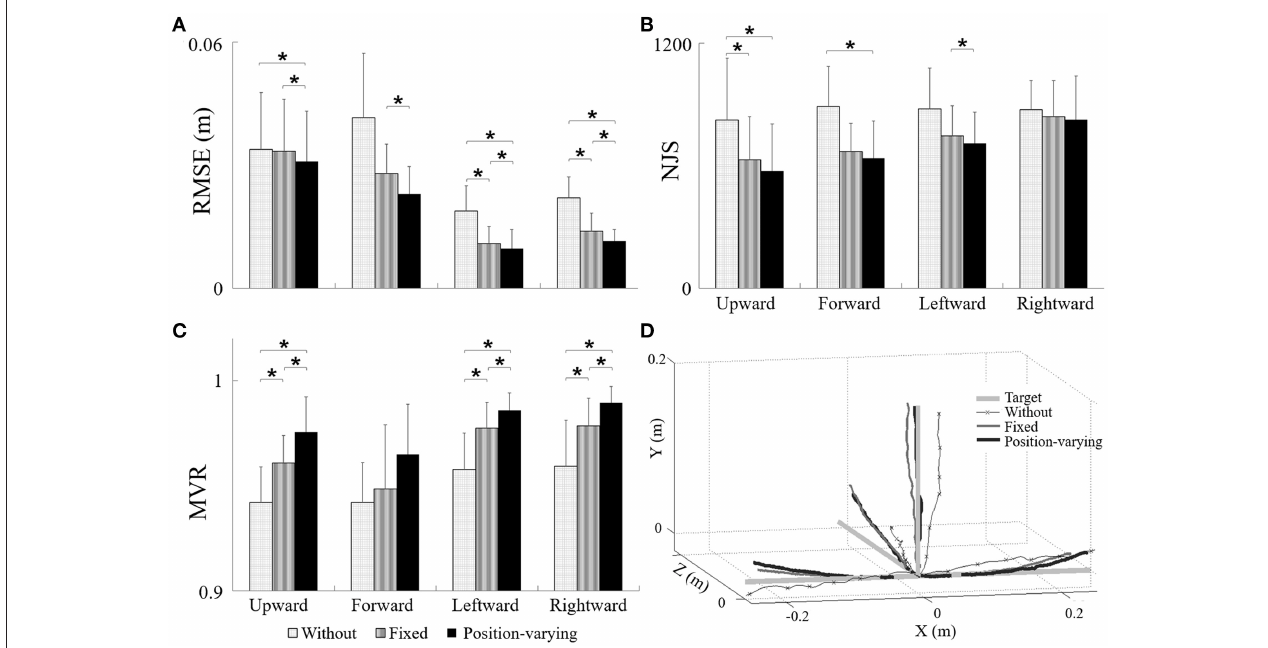
FIGURE 3 | The performance of (A) RMSE, (B) NJS and (C) MVR during movements with different gravity compensation strategies, (D) the target, and actual trajectories during movements tracking with different gravity compensation strategies. *Significant difference was found between two kinds of gravity compensation strategies ( p <